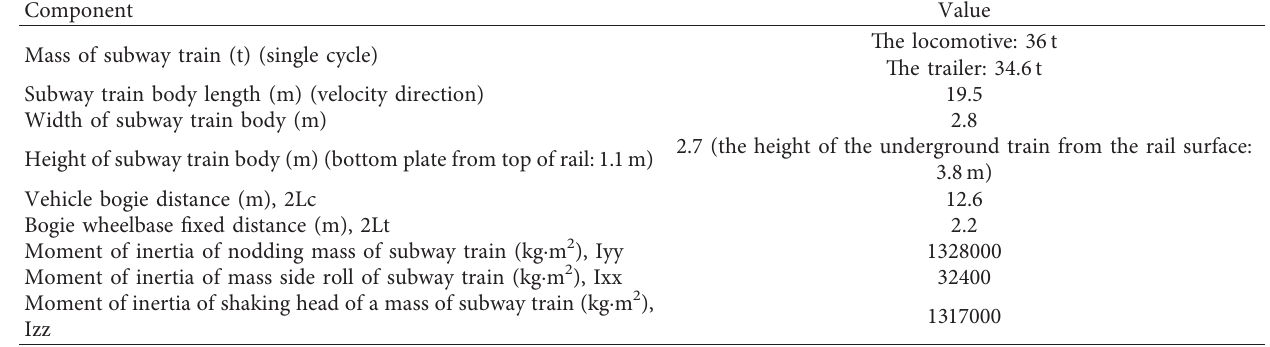
Figure 1: Technical flow route. Table 1: Subway train body